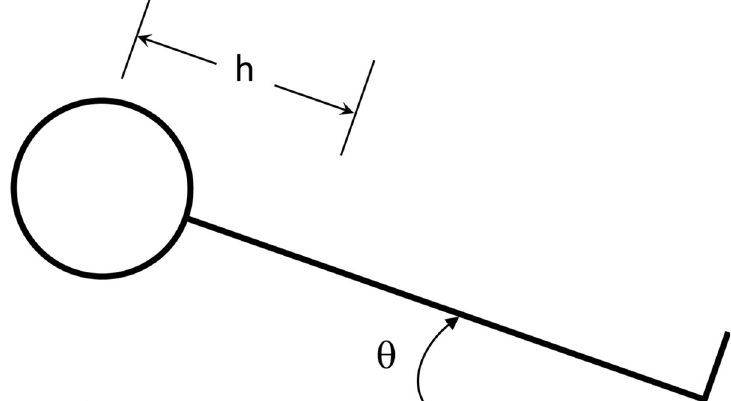
Fig 1. Schematic of body position as a function of tilt angle θ . Height (h) is the distance between the aortic root and the eyes along the body